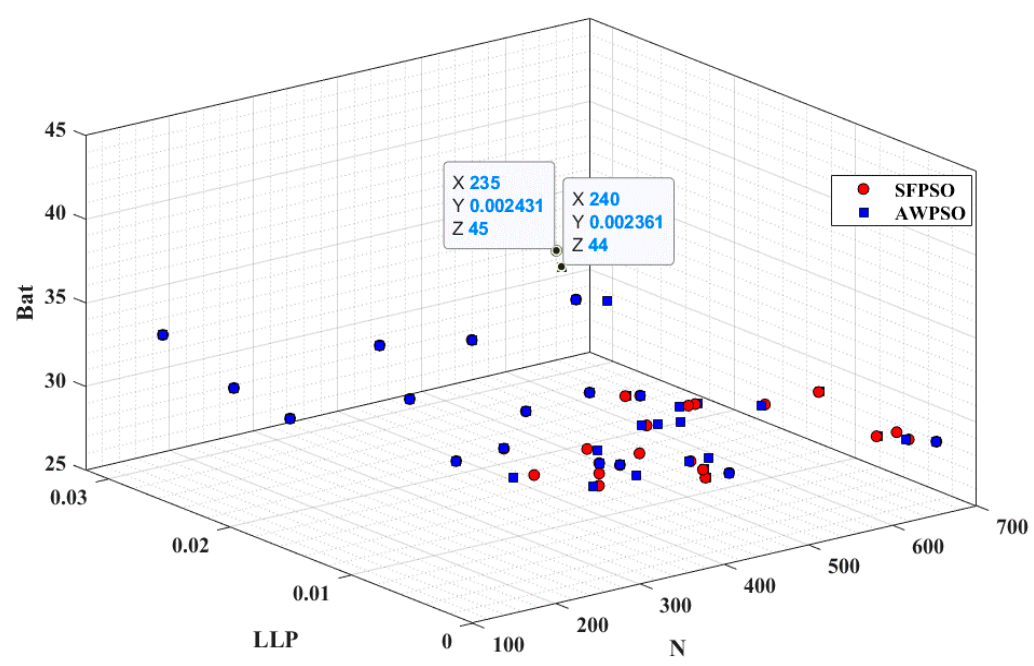
Figure 11. Evaluation of N and Bat at desired level of loss of load probability (LLP) value with di ff erent weights